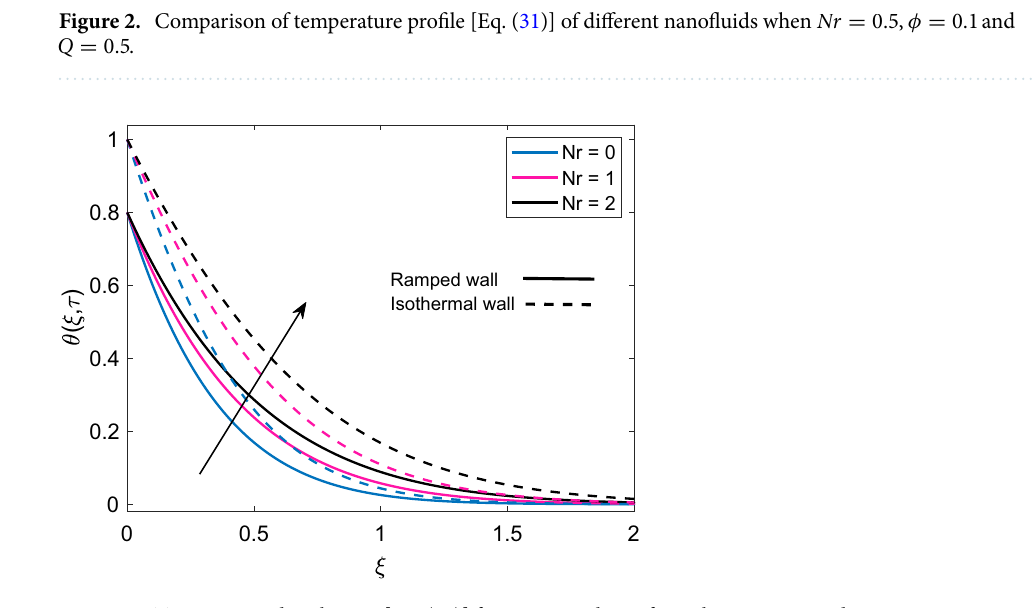
Figure 3. Temperature distribution [Eq. (31)] for various values of Nr when φ = 0.1 and Q = 0.5